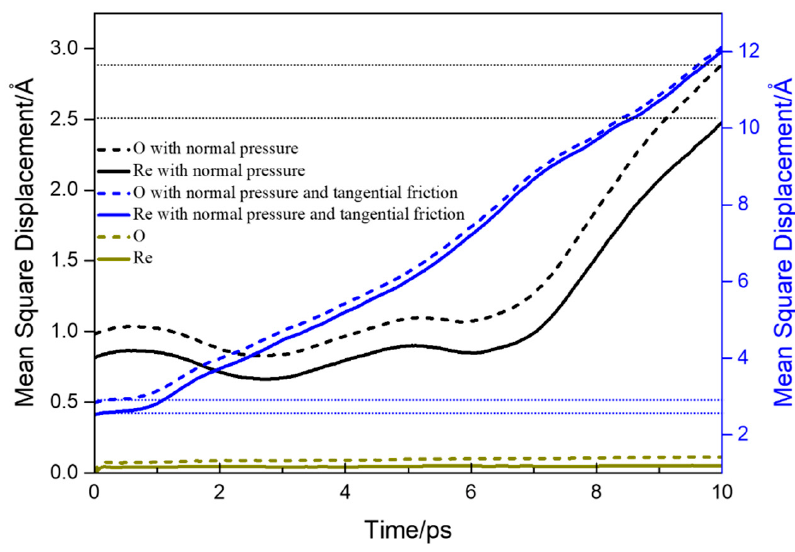
Figure 8. The mean square displacement of system atoms under different contact conditions.